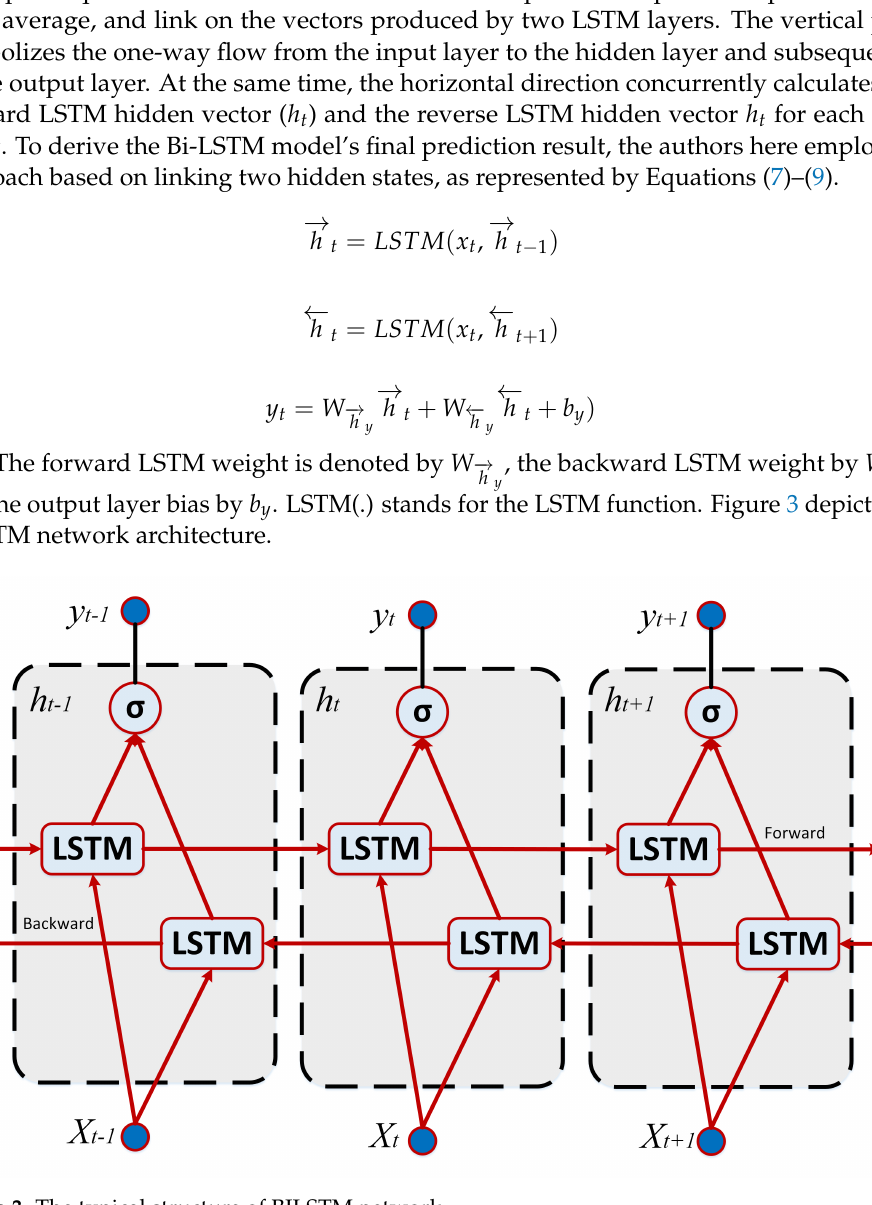
Figure 3. The typical structure of BILSTM